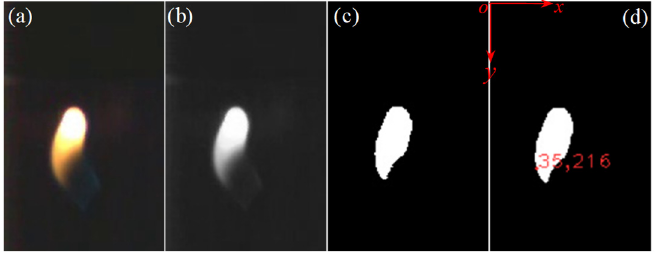
Figure 2. Procedures of the image processing to track the instantaneous flame: ( a ) single-frame image; ( b ) grayscale image; ( c ) binary map; ( d ) binary map.